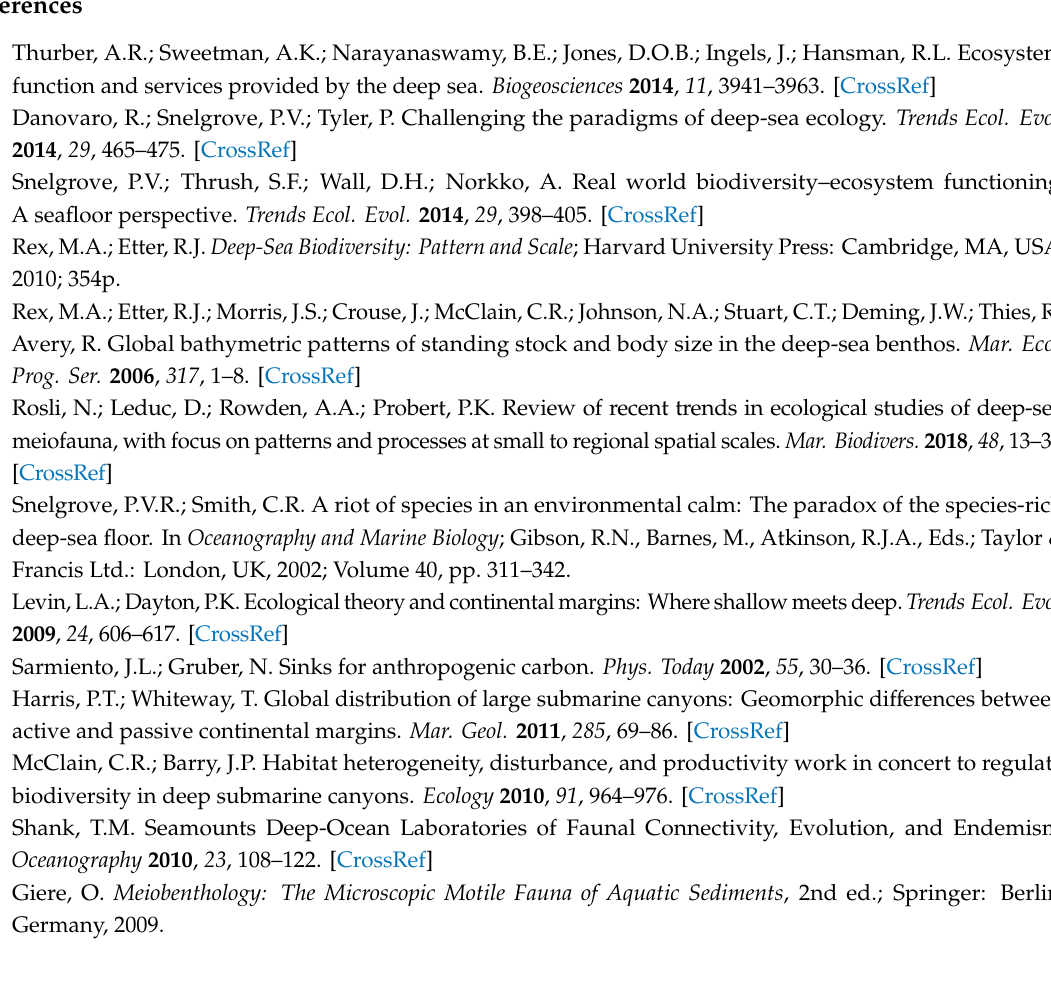
Table S1: PERMANOVA pairwise comparisons for community structure, and structural and functional parameters of the nematode